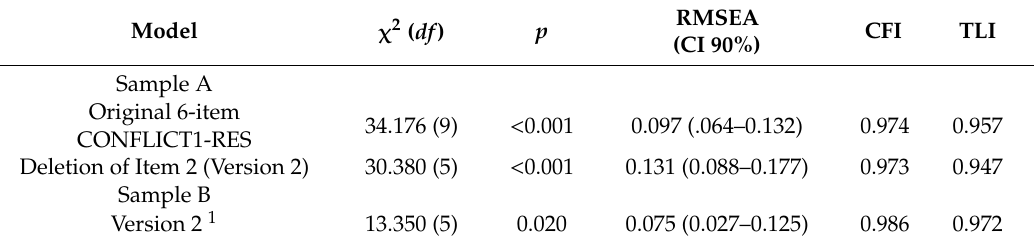
Table 3. Comparison among CFA measurement models